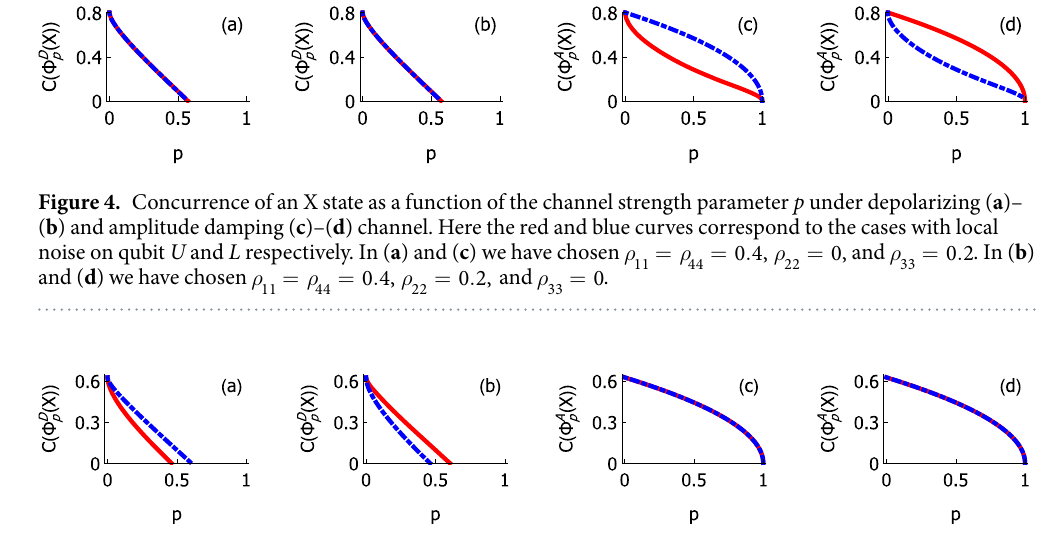
Figure 5. Concurrence of an X state as a function of the channel strength parameter p under depolarizing ( a ), ( b ) and amplitude damping ( c ), ( d ) channel. Here the red and blue curves correspond to the cases with local noise on qubit U and L , respectively. In ( a ) and ( c ) we have chosen ρ ρ ρ = . = . In ( b ) and ( d ) we have chosen ρ ρ ρ = . = . . Note that the situation is opposite to Fig. 4: now depolarizing channel causes asymmetric entanglement decay, and entanglement decays symmetrically in amplitude damping channel,